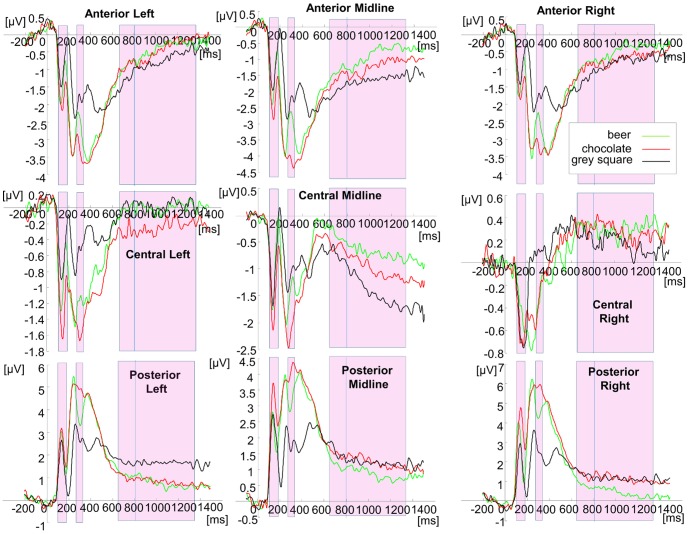
EEG analysis: ERPs at anterior, central and posterior sites on the left, midline and the right. Note that different voltage scales were used at different electrodes. The coloured squares indicate periods of activity indicated as revealing differences between stimuli by the TANOVA results (see Figure 3). Activity in the later period (654–1357 ms) was selected for further analysis. This window is split by the blue line to indicate the division between the earlier segment (up to 800 ms), which can be considered as part of the P300, and the later segment of activity, which is a slow potential.